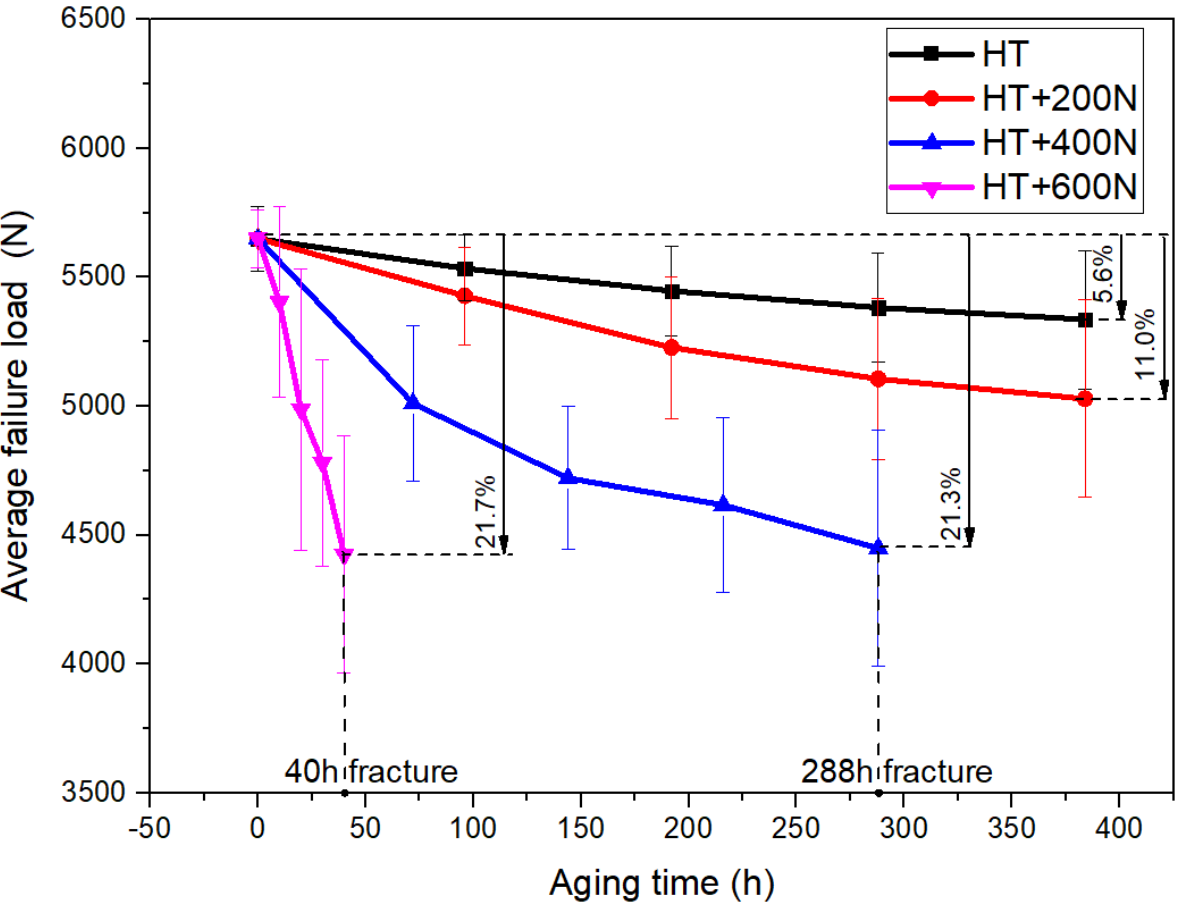
Figure 9. Variation curves of failure load under no-load and loading 200 N, 400 N and 600 N in HT conditions.